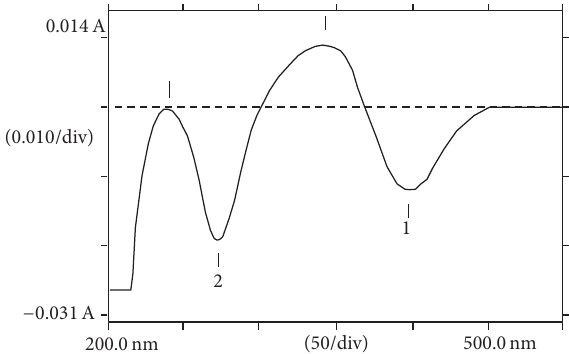
Figure 3: First derivative spectrum of DD (1) and PHZ (2) aqueous